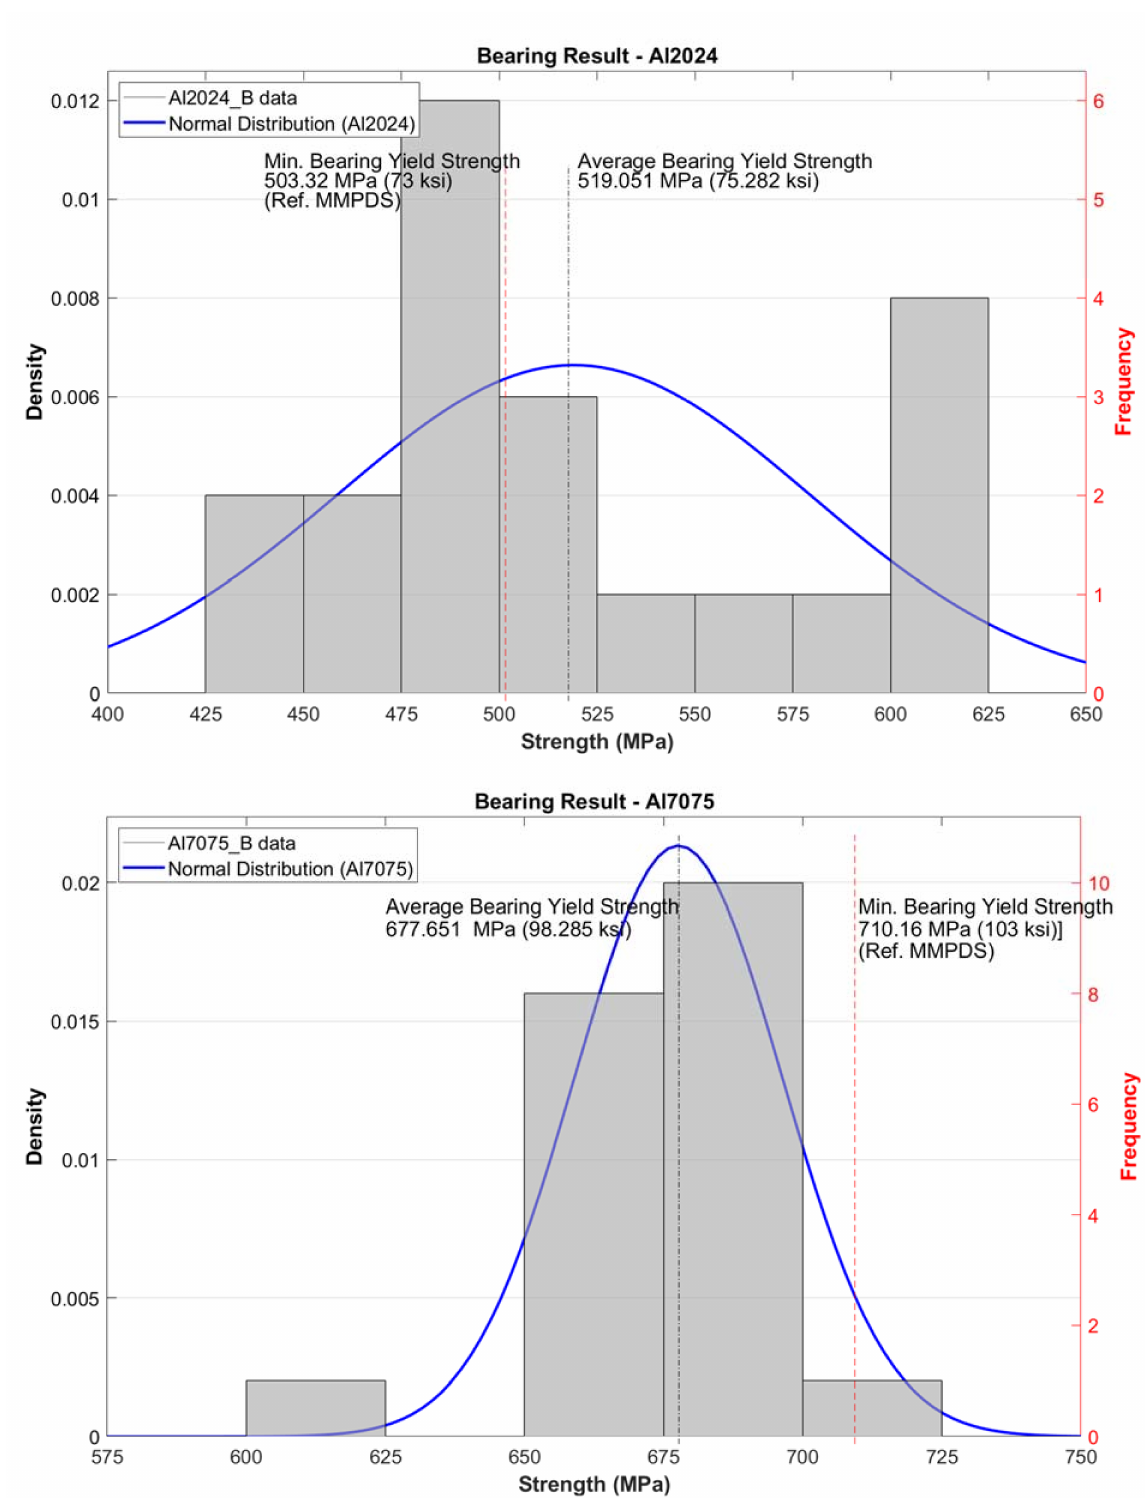
Figure 14. The normal distribution histogram and curve of the bearing strength results of both cold-sprayed Al-2024 and Al-7075 coating